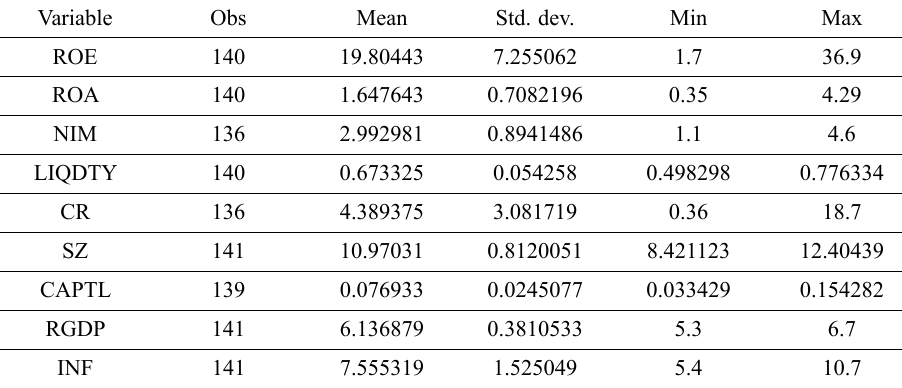
Table 2. Descriptive statistics of variables